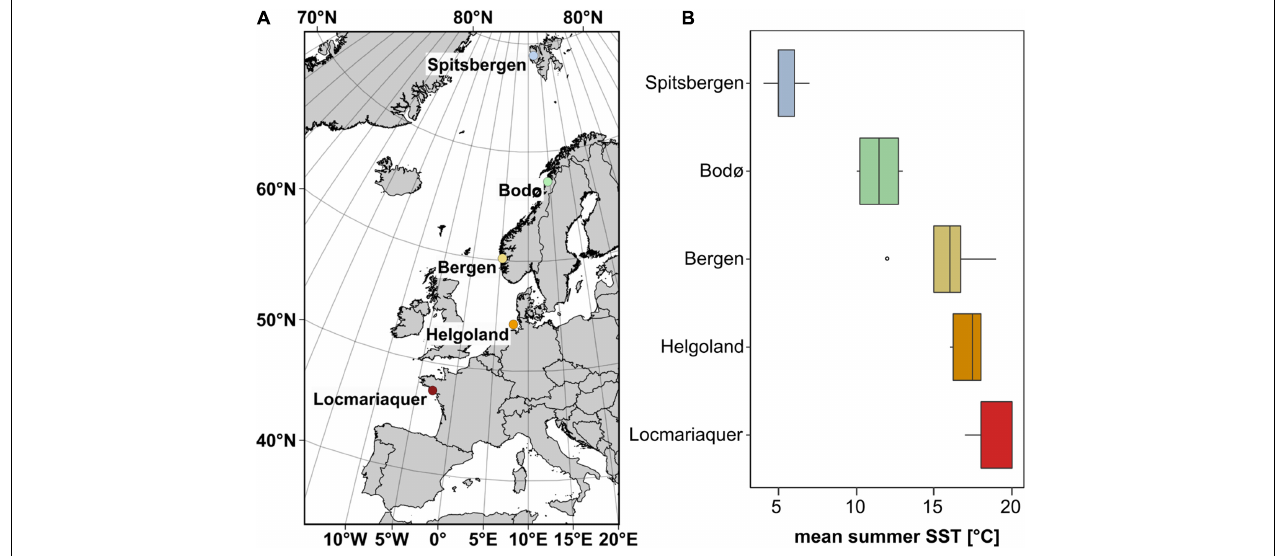
FIGURE 1 | (A) Sampling locations of Saccharina latissima (map data: EuroGeographics for the administrative boundaries) and (B) mean summer (June–August) sea surface temperature (SST) from 2016 to 2020 at each sampling location based on satellite-obtained mean monthly SST datasets (Giovanni Satellite: Acker and Leptoukh,